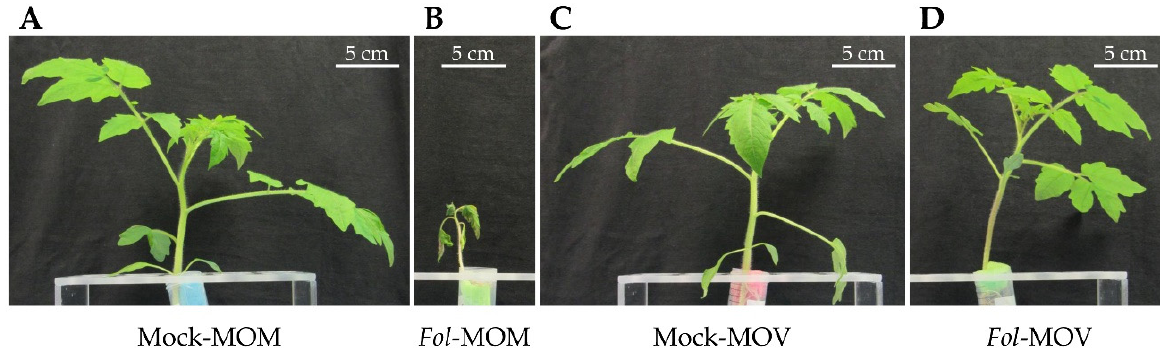
Figure 1. Fusarium wilt symptoms in Momor (MOM) and Movione (MOV) tomato plants at 14 dpi after Fusarium oxysporum f. sp. lycopersici ( Fol ) inoculation. Tomato plants display the representative phenotype observed in infected susceptible MOM ( B ) compared to mock-inoculated ( A ), and infection-resistant MOV ( D ), as compared to their corresponding mock-inoculated ( C ).